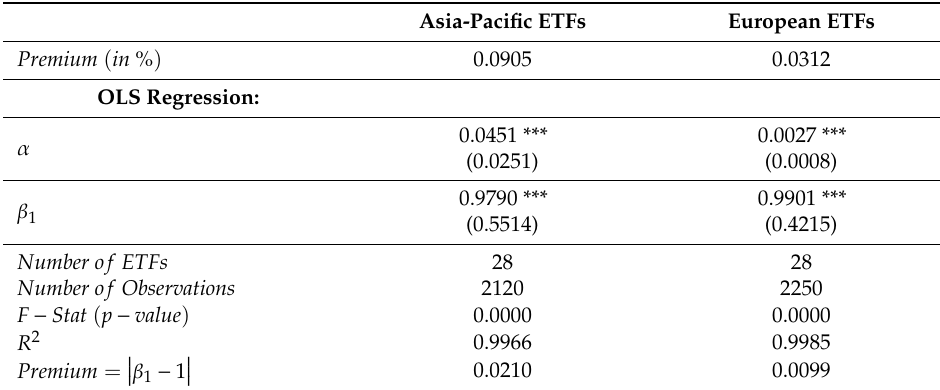
Table 6. Pricing ine ffi ciency of international ETFs.